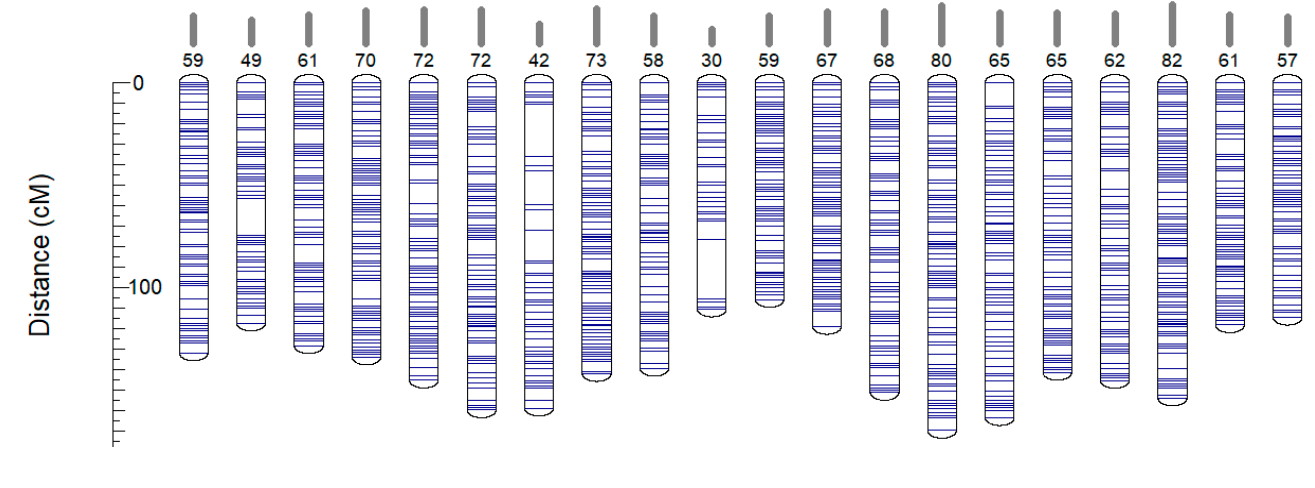
Figure 3. Linkage map of Muscadinia rotundifolia cv. Dixie developed using a mapping population derived from self-pollination of a hermaphrodite cv. Dixie. The number of segregating markers per chromosome is indicated above the corresponding LG.